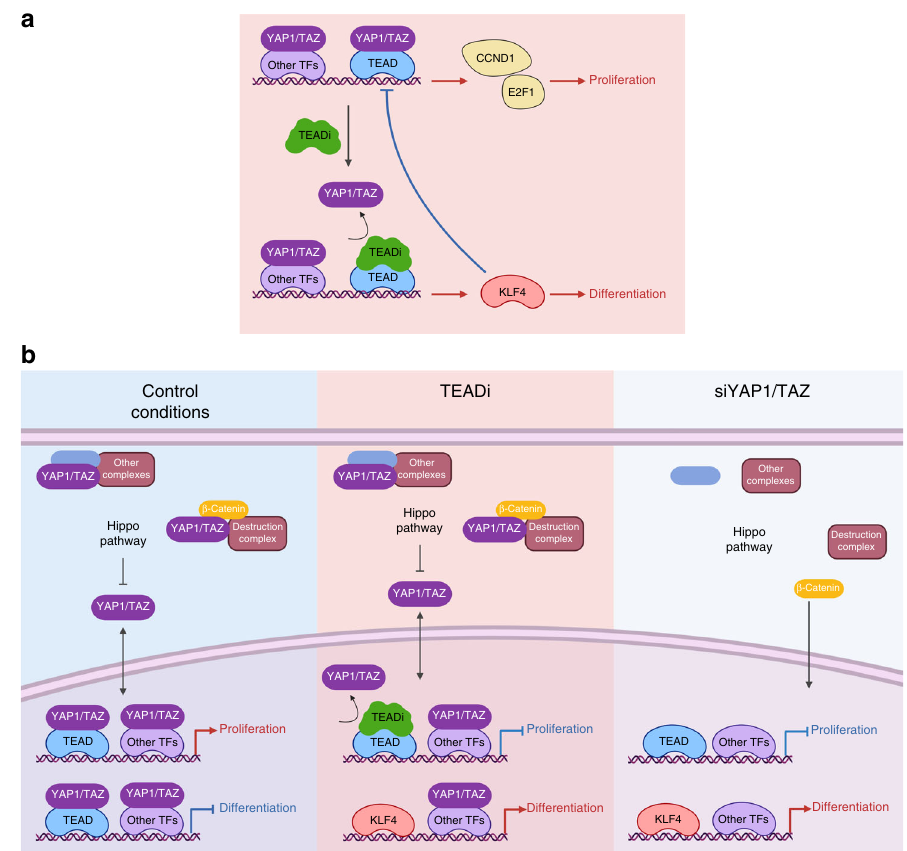
Fig. 7 TEAD regulation of keratinocyte proliferation and differentiation. a Simpli fi ed model summarizing the results from our study. Blockage of TEAD activation by TEADi triggers differentiation and reduced proliferation. In turn, activation of KLF4 can also lead to inhibition of YAP1/TAZ-TEAD transcription. b Comparison between the model of action of TEADi vs siYAP1/TAZ which might explain the lack of complete overlap in gene networks under both conditions. In cells expressing TEADi, YAP1/TAZ can still directly or indirectly regulate other factors that regulate transcription (TFs) and maintain cytoplasmic complexes, conditions that are not reproduced under YAP1/TAZ knockdown. Created with